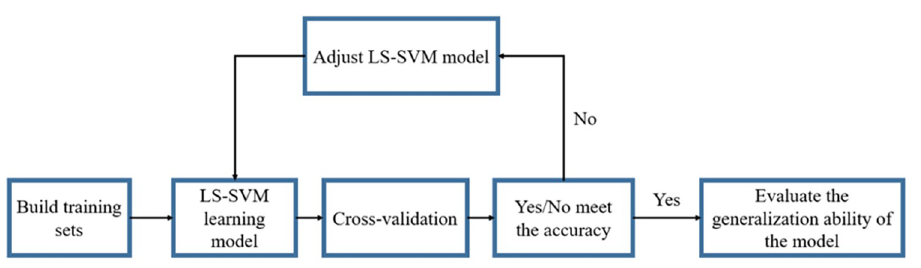
Fig 2. Schematic diagram of model construction based on